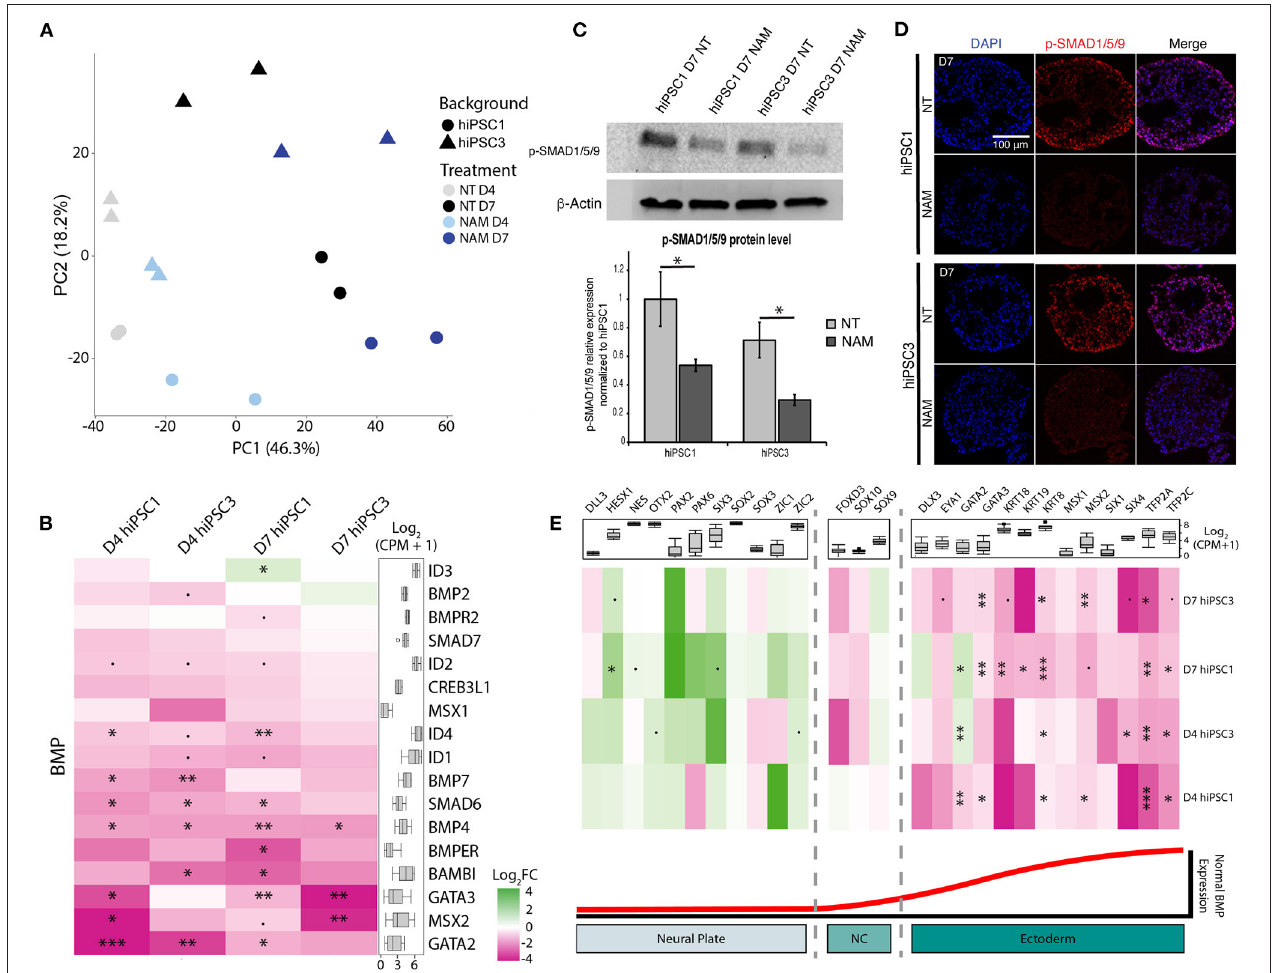
FIGURE 4 | Transcriptomic analysis reveals that nicotinamide treatment inhibits BMP pathway and improves neuroectodermal differentiation. (A) Principal component analysis (PCA) plot of non-treated (NT) and Nicotinamide-treated (NAM) hiPSC1 and hiPSC3-derived EBs samples based on log2 CPM gene counts. (B) Log2 fold change (FC) heatmap comparing the expression of BMP ligands and BMP target genes between non-treated and NAM-treated EBs at D4 and D7 (shown as NAM-treated vs. non-treated). (C) Western blot analysis (top) and quantification (bottom) of the phosphorylated form of SMAD1/5/9 (Key BMP pathway effectors) in NT and NAM-treated cultures at D7. 3 independent differentiation batches were quantified. * p < 0.05. (D) Immunohistochemistry analysis of the expression of the phosphorylated form of SMAD1/5/9 in NT and NAM-treated cultures at D7. (E) Log2 fold change (FC) heatmap comparing the expression of neural and non-neural ectoderm markers between non-treated and NAM-treated EBs at D4 and D7 (shown as NAM-treated vs. non-treated). The box plot shows the minimum, first quartile, median, third quartile, and maximum of count per million (CPM) in each category. • p < 0.1; * p < 0.05; ** p < 0.01; *** p <